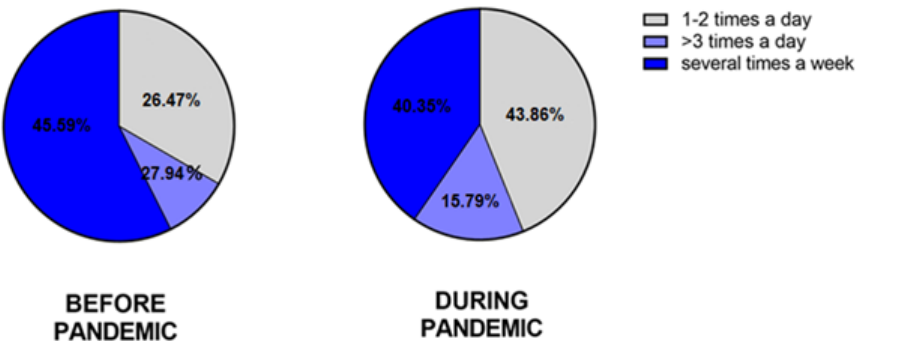
Figure 20. The frequency of moisturizing the skin of the hands in the non-HE group of respondents before and during the pandemic.